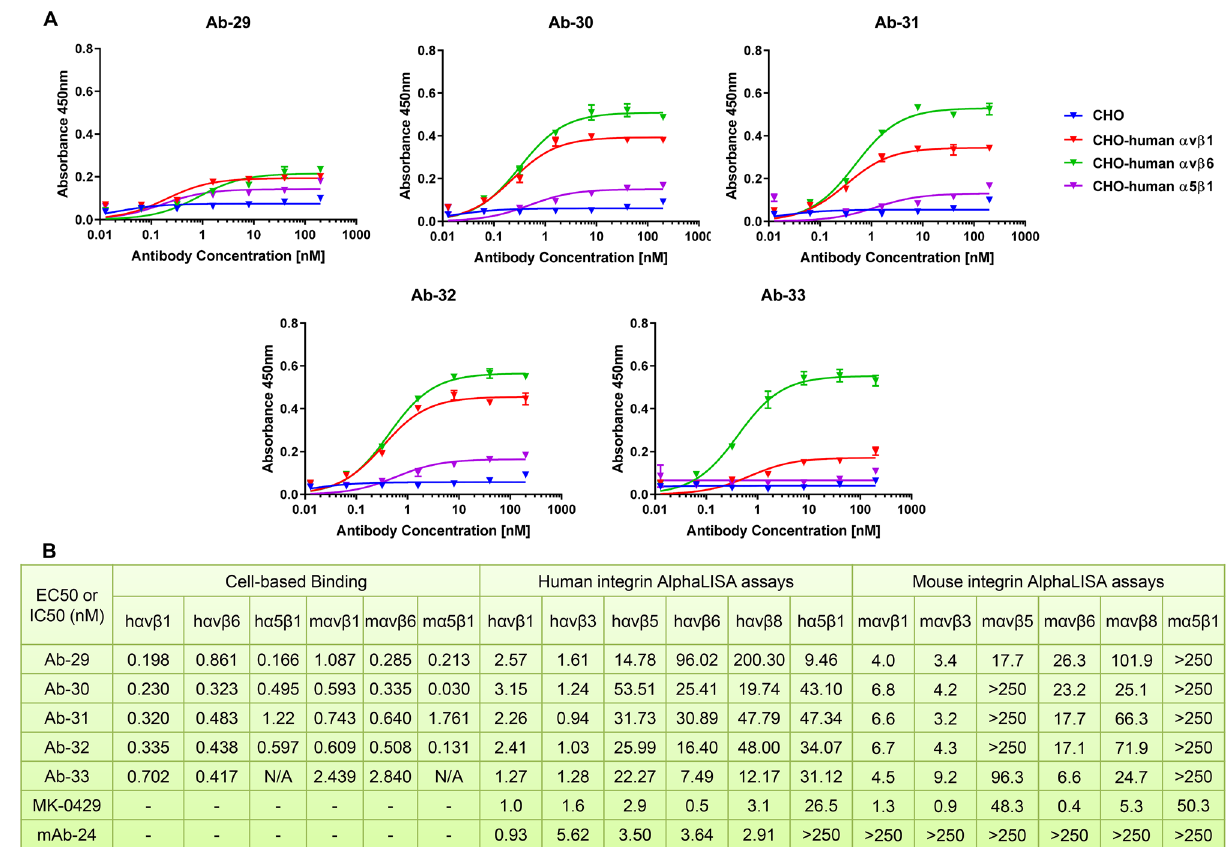
Figure 4. Discovery a set of antibodies with strong blocking activities against both human and mouse αv integrins. ( A ) Titration of Ab-29, Ab-30, Ab-31, Ab-32, and Ab-33 for their binding to CHOK1-human αvβ1, αvβ6, and α5β1 stable cell lines in CELISA assays. ( B ) EC50 of Ab-29, Ab-30, Ab-31, Ab-32, and Ab-33 in CELISA assays, as well as their IC50 in human and mouse AlphaLISA integrin blocking